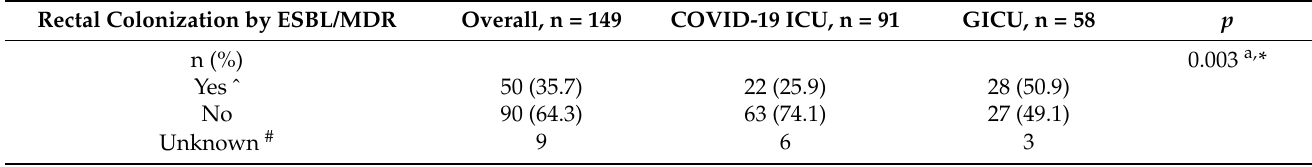
Table 2. Rectal colonization among patients who were prescribed